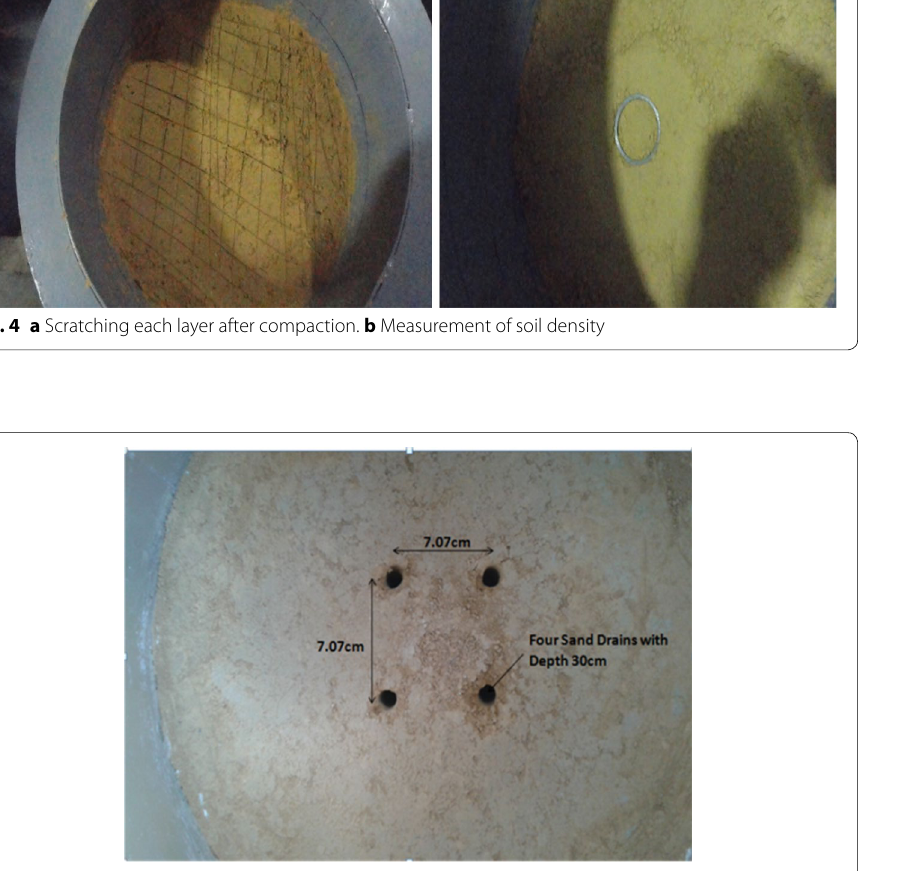
Fig. 5 Sand drains around helical pile before and after filling with